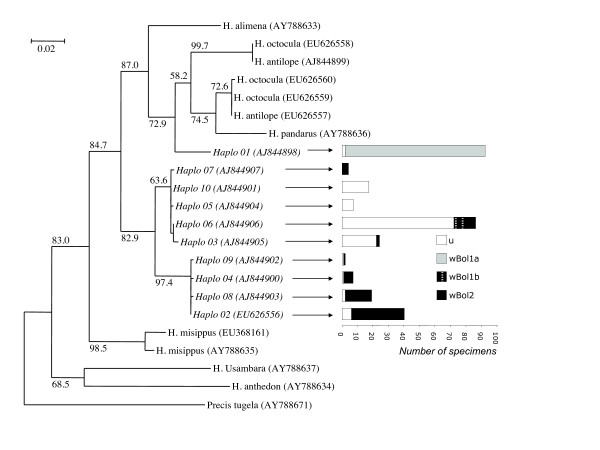
Phylogeny and distribution of Wolbachia infections among haplotypes. The left part of the figure shows the phylogeny of the 10 H. bolina mtDNA haplotypes with respect to H. alimena, H. octocula, H. antilope, H. pandarus, H. missipus, H. anthedon, H. usambara, with Precis tugela as an outgroup. The tree was constructed via Maximum Likelihood estimation in Treefinder; aLRT (approximate likelihood ratio test) scores are given next to the nodes (only for internal nodes for clarity) and branch length indicates the number of substitution per site. H. bolina haplotypes are in italics. Genbank accession numbers are given in parenthesis. The right part of the figure gives the distribution of the various Wolbachia infections status (u: uninfected, wBol1a, wBol1b, wBol2) observed with each haplotype. Note the relative proportions of the infections are not representative of the prevalence within the species since sampling was aimed at representing the different infection status in even proportions.